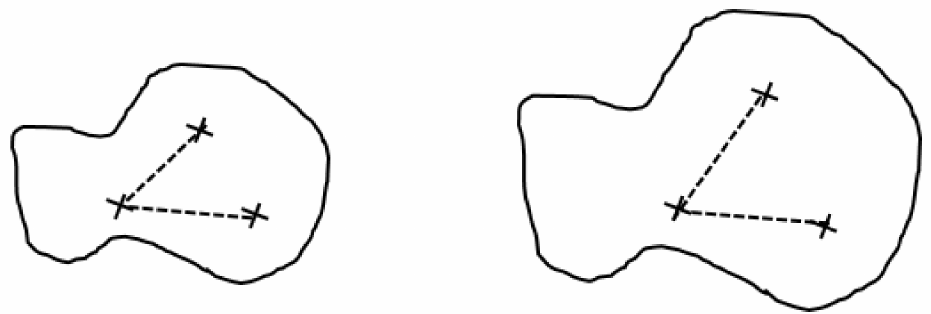
Figure 6. Similarity in the case of non-rectilinear